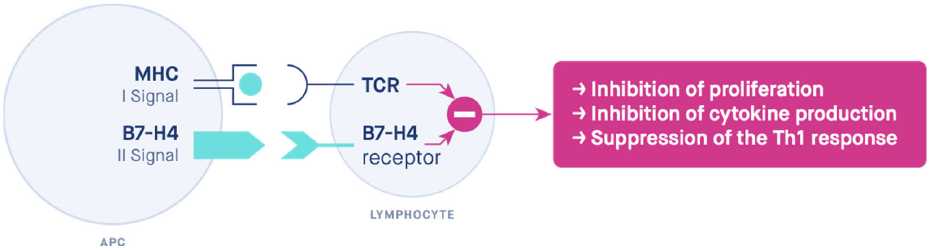
Figure 4. The two ‐ signal hypothesis. The mechanism of action of the costimulatory molecule B7 ‐ H4. MHC—major histocompatibility complex, TCR—T ‐ cell receptor, APC—antigen ‐ presenting cell. MHC—major histocompatibility complex, TCR—T-cell receptor, APC—antigen-presenting cell